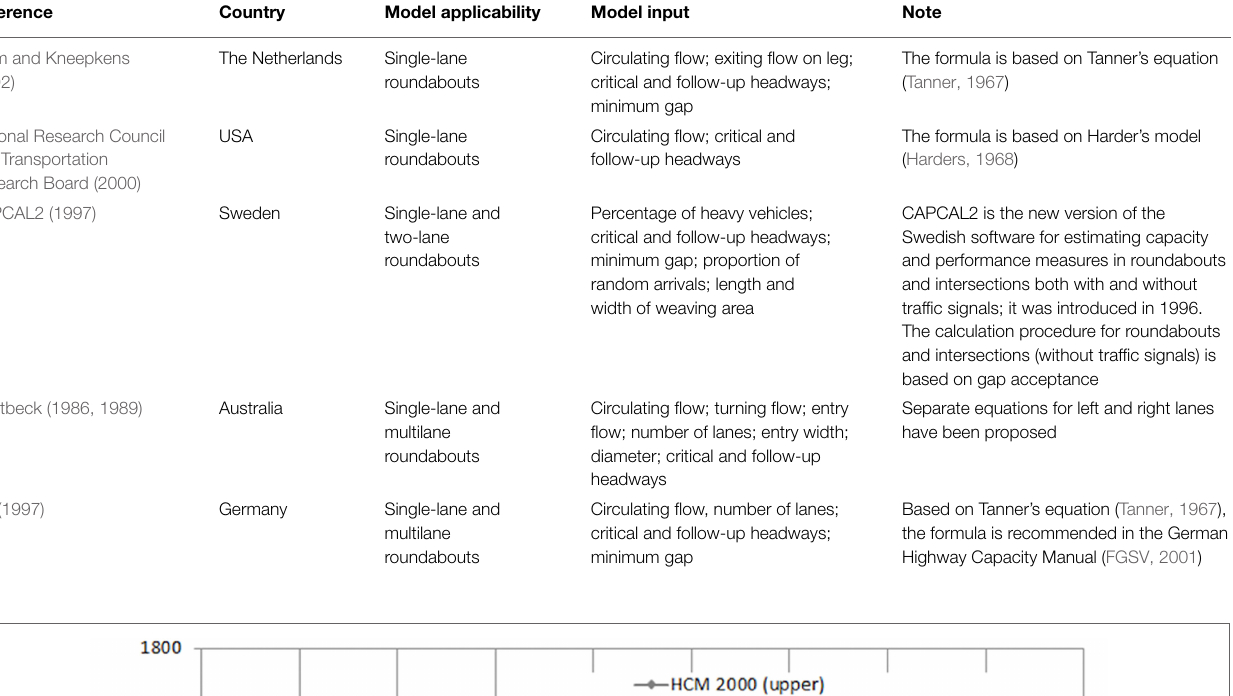
TABLE 1 | A summary of gap acceptance capacity models for roundabouts (references in the first column) .